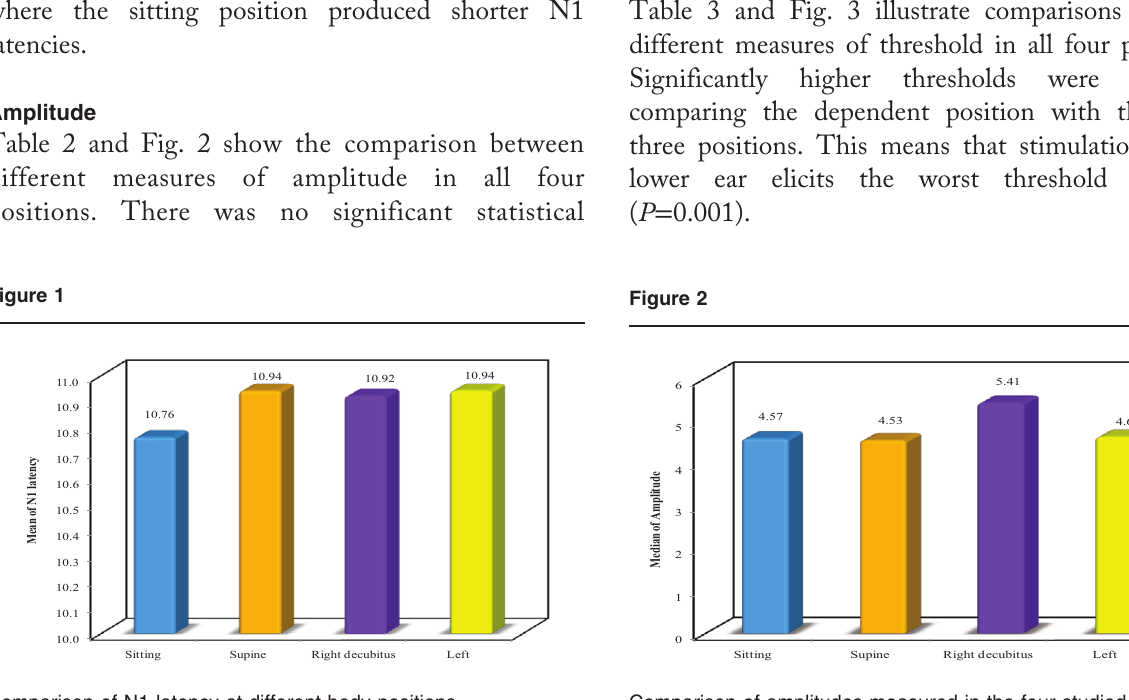
Comparison of amplitudes measured in the four studied